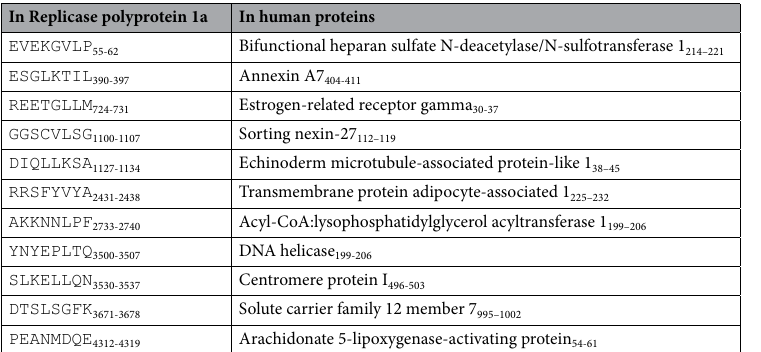
In Replicase polyprotein